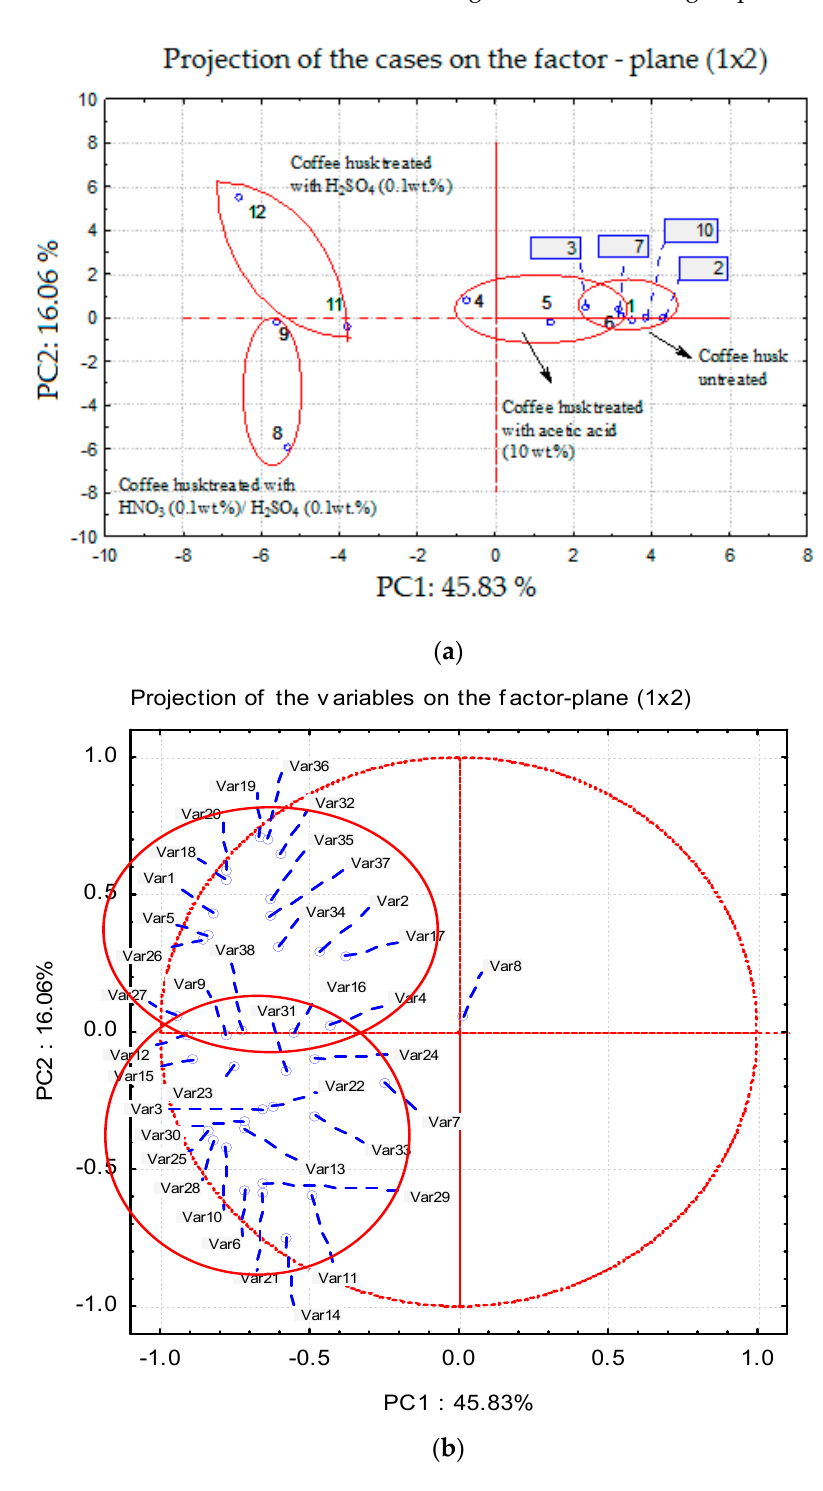
Figure 7. PCA analysis of pyrolysis sugarcane bagasse untreated and treated with different acids at 400, 500, and 600 °C: ( a ) score plot; ( b ) loading plots for the PCA model with all the compounds.